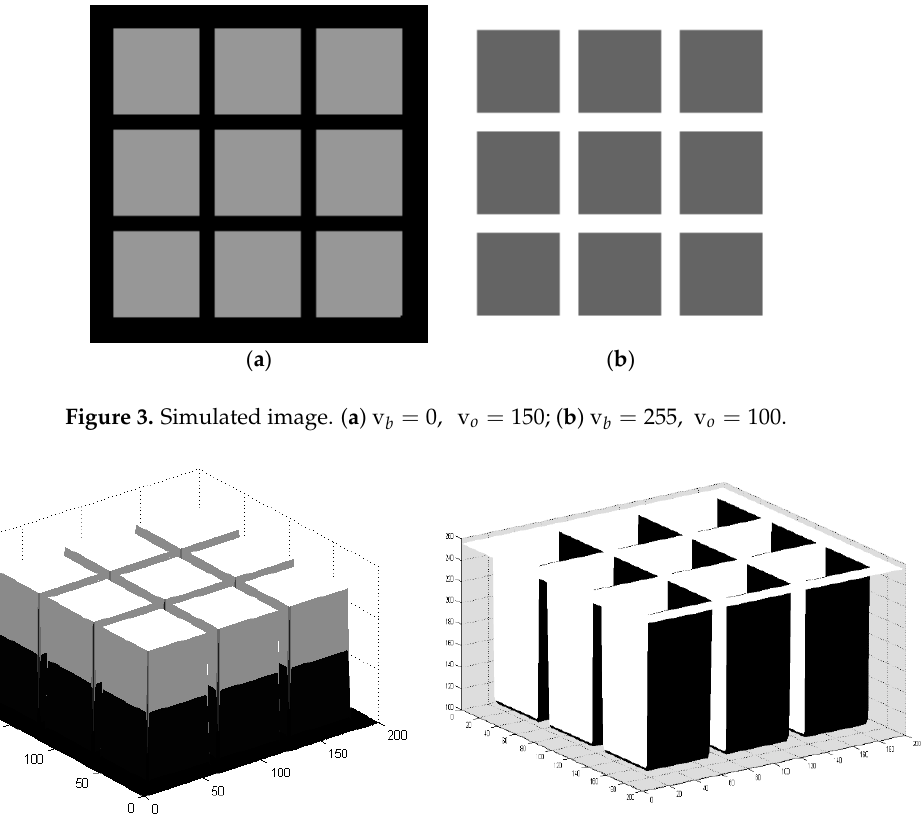
Figure 4. Data field. ( a ) v (cid:3029) = 0, v (cid:3042) = 150 ; ( b ) v (cid:3029) = 255 , v (cid:3042) = 100 .